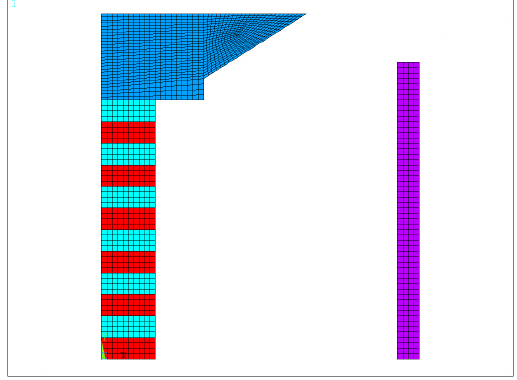
Figure 2. The finite element model of the transducer.